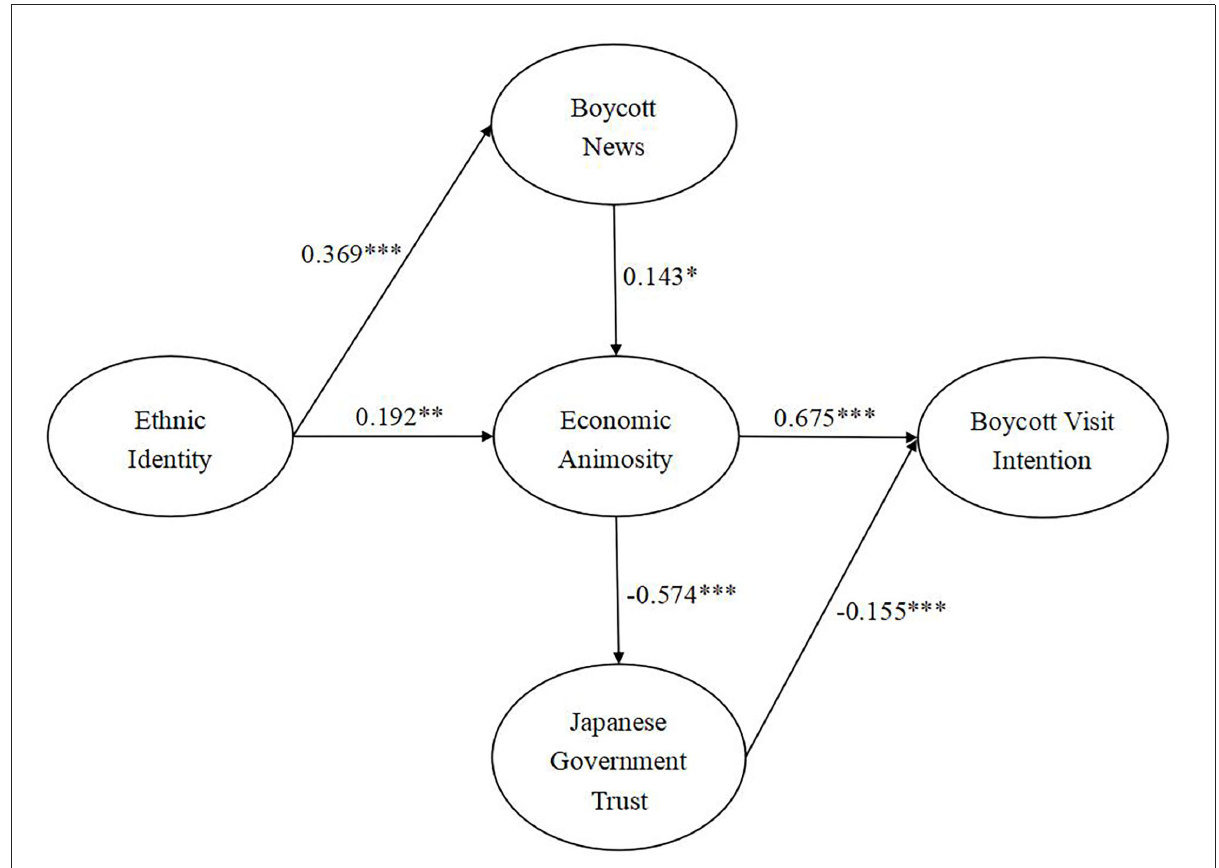
FIGURE2 Hypotheses testing results. The *, **, and *** symbols indicate the values of * p < 0.05, ** p < 0.01, and *** p < 0.001